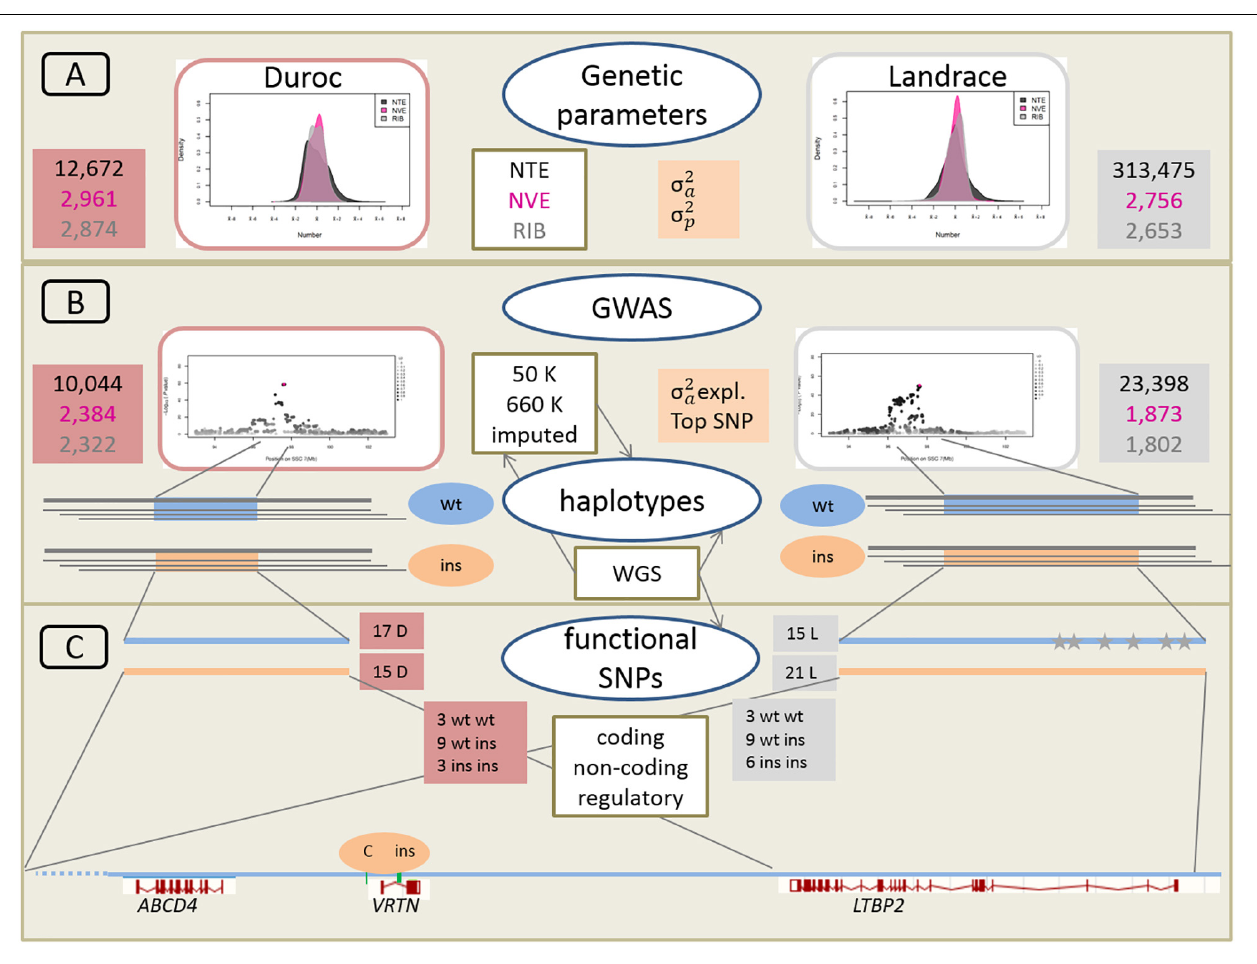
FIGURE 2 | Schematic overveiw of the approach linking large-scale phenotypic, genetic, and genomic data. (A) Phenotypic distribution and estimation of additive genetic variance ( σ 2 a ) and phenotypic variance ( σ 2 p ) for Duroc and Landrace breeds for NTE, number of vertebrae (NVE), and number of ribs (RIB). Number of animals for each population and each trait is indicated in red and gray boxes for Duroc and Landrace, respectively. (B) Genome wide association analyses (GWAS) with medium density (50K) and imputed high density (660K) SNP sets as well as imputed from whole genome sequence (WGS) data. Number of animals with 50K data in red and gray boxes. Estimation of haplotypes from 660K SNP data and search for identical core haplotype associated with two functional variants (ins) in the Vertnin ( VRTN ) gene compared to the wildtype (wt) haplotypes. (C) Search for potentially functional SNPs and indels in coding (missense, non-sense) and non-coding (splice sites) regions in the core haplotypes of 16 D (3 wt wt, 9 wt ins, 3 ins ins) and 18 L (3 wt wt, 9 wt ins, 6 ins ins) animals for the wt and ins alleles. Mapping of regulatory enhancer sequences in LTBP2 from human genome. Identification of SNP and indel variants only present on each of the 15 wt haplotype in L